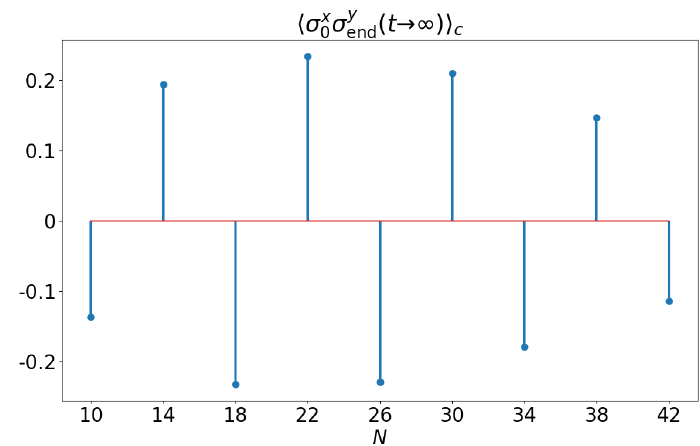
Figure 12: The value of the X Y connected correlation function of qubit 0 with the end qubit as a function of N in the same simulations as in Fig. 7. The initial increase (with N ) and the eventual decay are the plausibly result of competition between the driving that creates excitations, their dynamics of propagation and reflections in the system, and the continuous energy relaxation – see the text for a